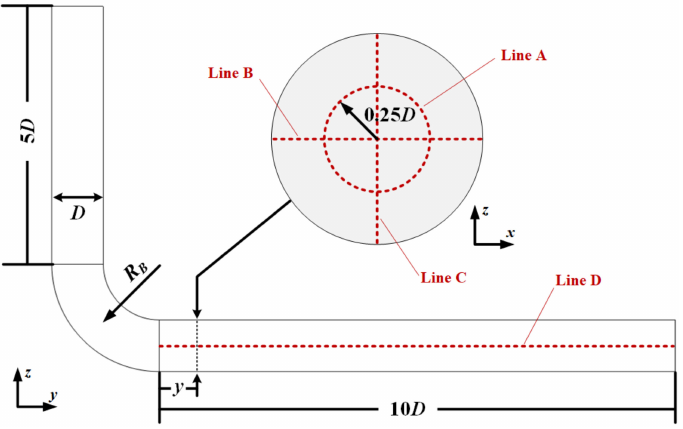
Figure 1. Schematic of the physical model (90 ◦ bend pipe for